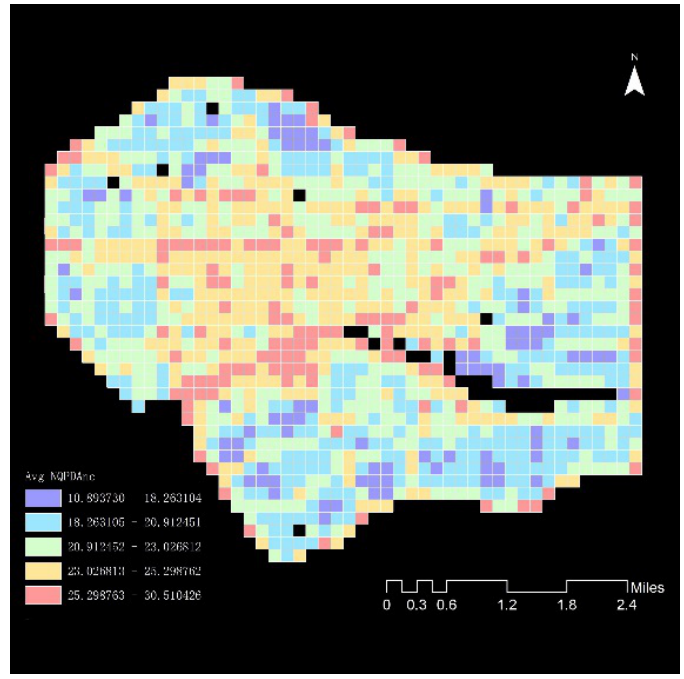
Fig. 13 Fishing net graph of the overall closeness